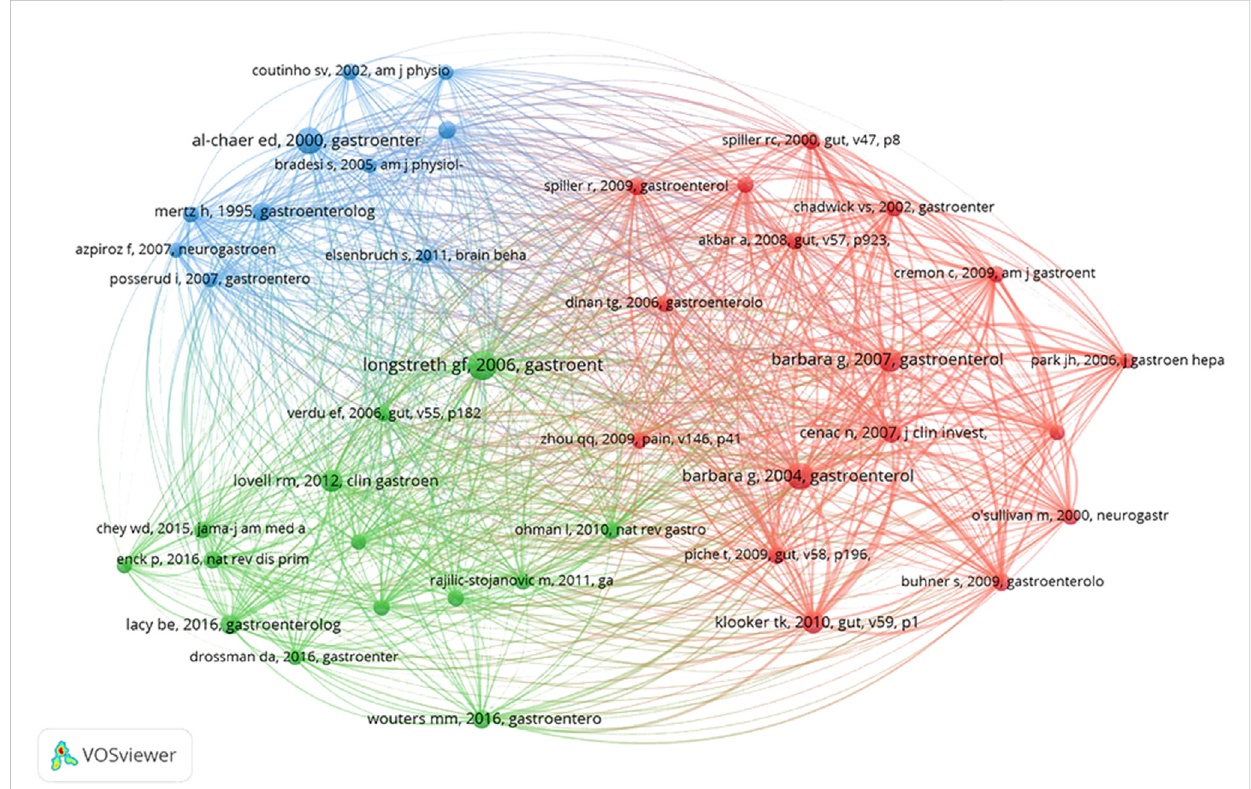
FIGURE 6 Visualization of a clustering map of co-cited references.